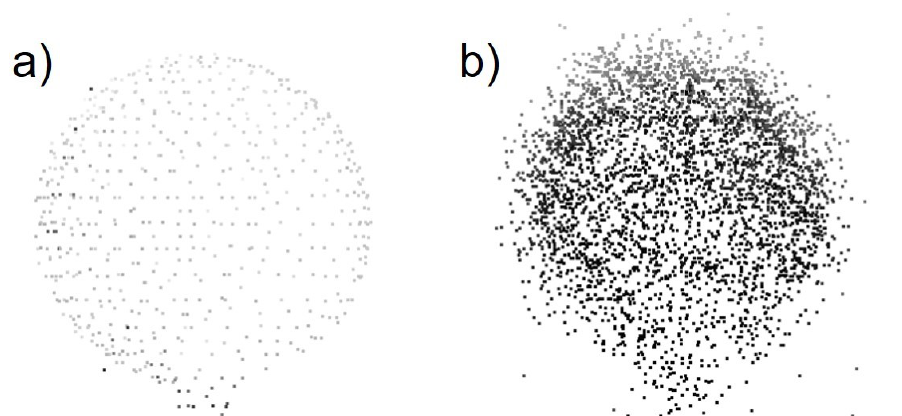
Figure 7. Comparison of a target sphere (radius 90 mm) as found in the point clouds. ( a ) A target sphere in TLS point cloud ( b ) in SLAM LS point cloud.